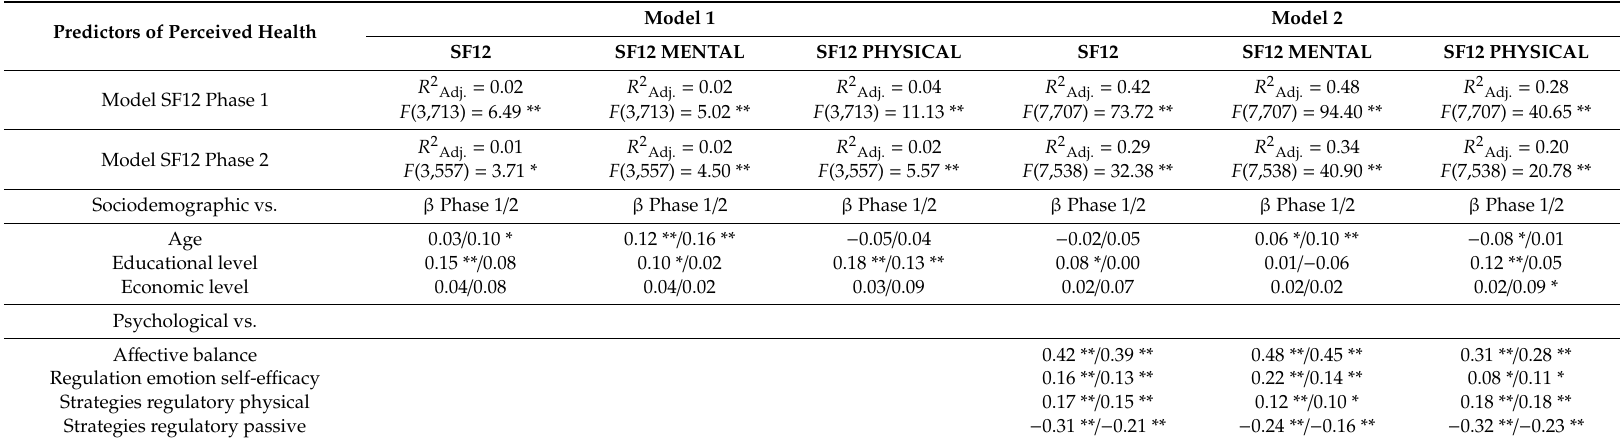
Table 4. Predictive variables of perceived health in phase 1 and phase 2. In the first regression model, sociodemographic variables are inserted as predictors of global, mental, and physical health in phase 1 and phase 2. In the second regression model, sociodemographic and psychological variables are inserted as predictors of global, mental, and physical health in phase 1 and phase